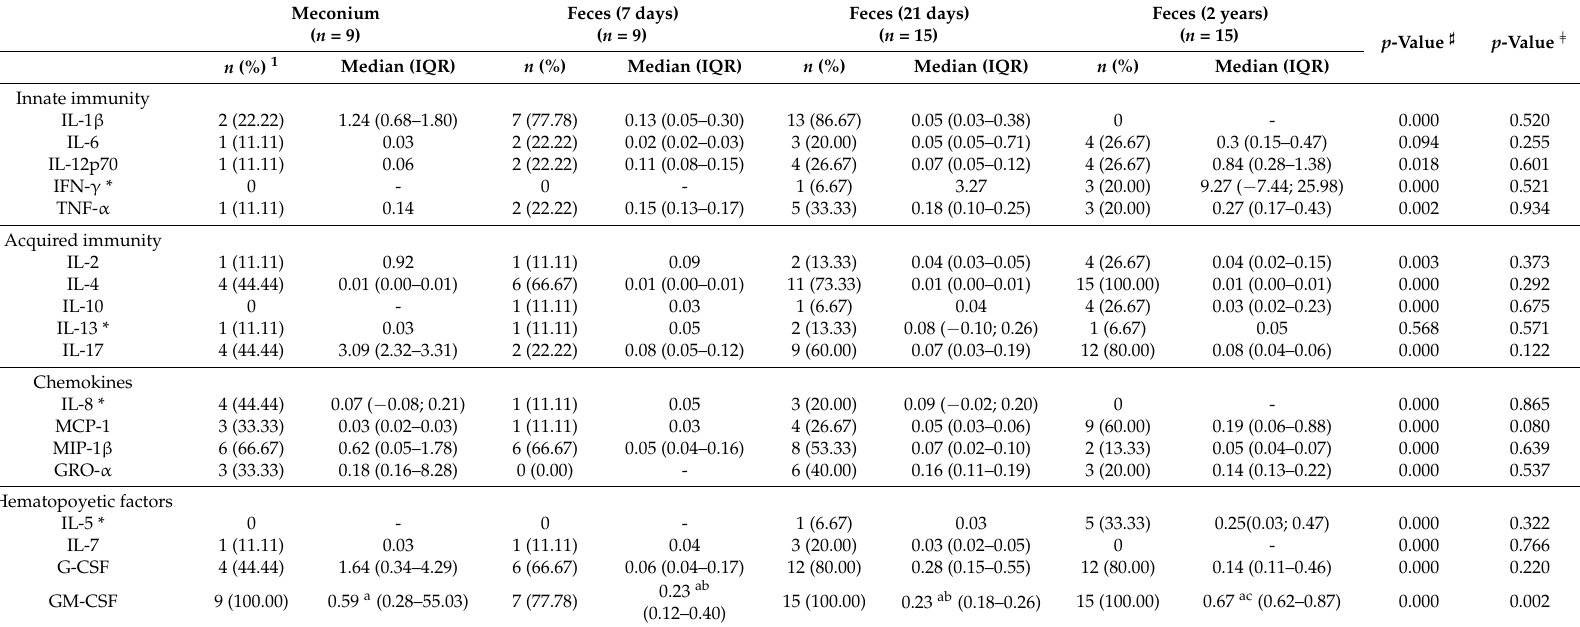
Table 4. Immunological analysis of intestinal samples. The presence and concentrations are shown for cytokines and other immune compounds in the meconium and fecal samples collected in this